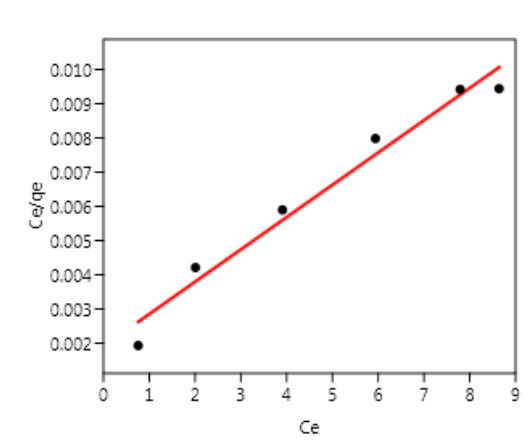
Figure. 3. Adsorption isotherm of Freundlich phosphate with chitosan-activated carbon nanocomposite